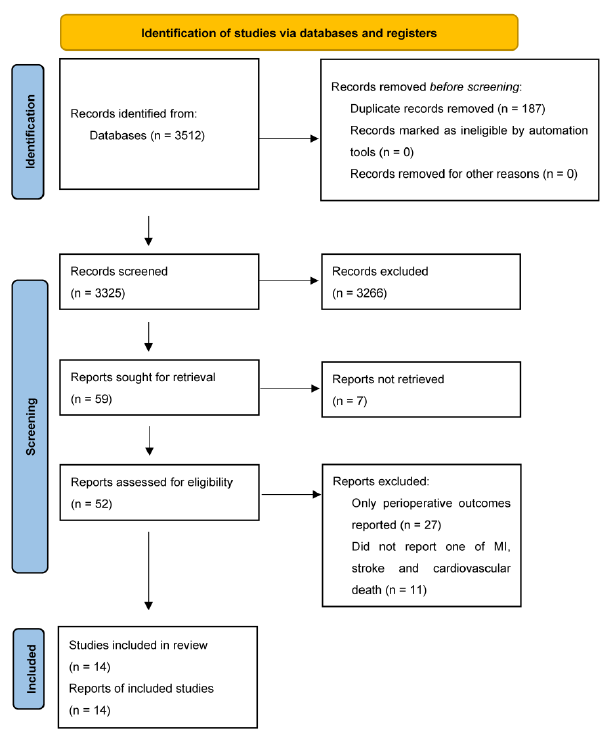
Figure 1. PRISMA Flow Diagram.